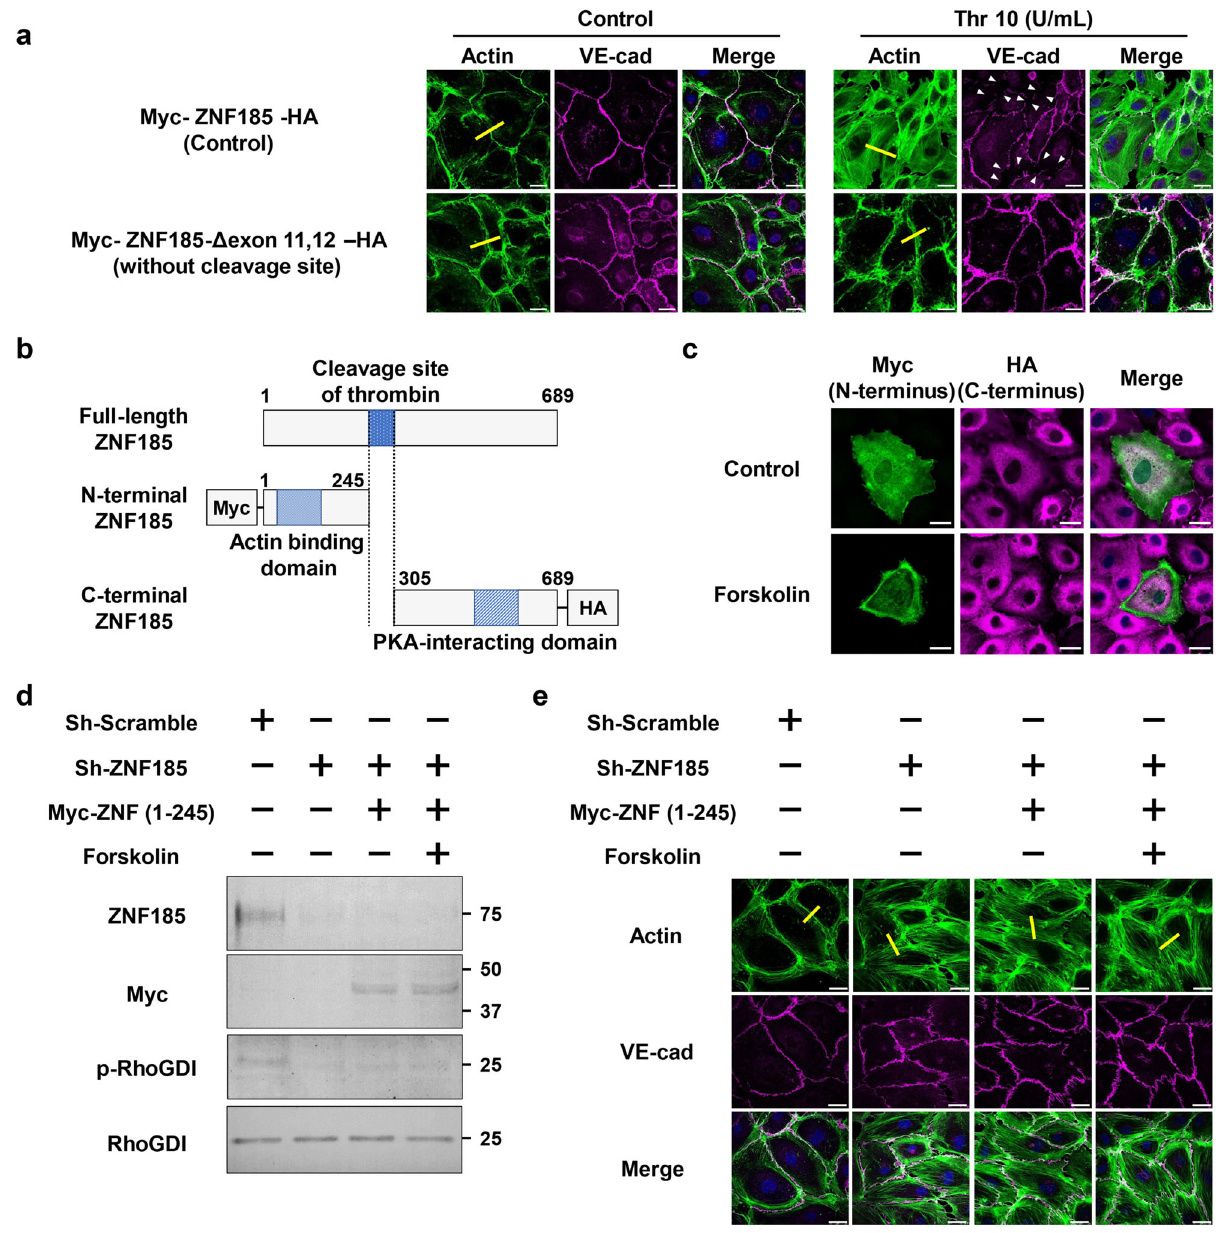
Fig. 8 N-terminal ZNF185 lacking PKA-interacting domain is insuf fi cient to inhibit stress fi ber formation. a Thrombin-induced stress fi ber formation and disruption of adherens junction are inhibited by ZNF185- Δ exon 11,12. Thrombin (10 U/mL) was added to HUVECs overexpressing Myc-ZNF185-HA or Myc-ZNF185- Δ exon 11,12-HA for 1 h. Immuno fl uorescence staining of actin (green) and VE-cadherin (magenta). Arrowheads indicate intercellular gaps. Representative images are shown ( n = 3). Scale bars, 25 µ m. b Schematic representation of N- and C-terminal of ZNF185. c Myc-N-terminal ZNF185 (green) is translocated to the membrane region after the treatment of forskolin for 1 h. C-terminal ZNF185-HA (magenta) is dispersed throughout the cytosol ( n = 3). Scale bars, 25 µ m. d Inhibition of RhoGDI α phosphorylation by ZNF185 knockdown is not rescued by overexpression of N-terminal ZNF185. e N-terminal ZNF185 does not rescue stress fi ber formation by ZNF185 knockdown. Immuno fl uorescence staining of actin (green) and VE-cadherin (magenta). Representative images are shown ( n = 3). Scale bars, 25 µ